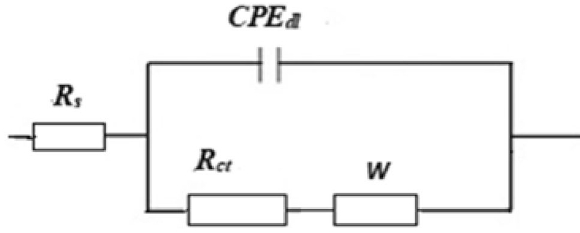
Figure 10. The equivalent circuit model.